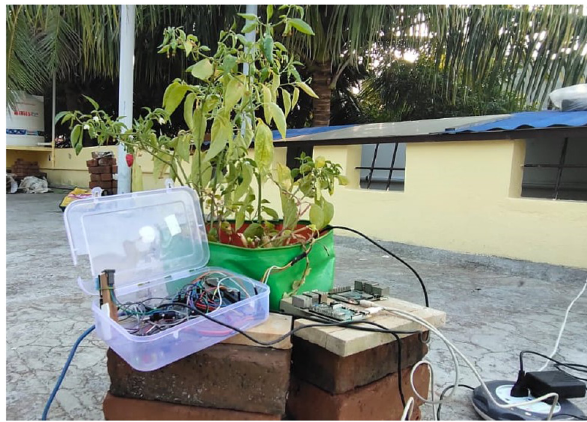
Figure 3: Real - time prototype of the proposed edge